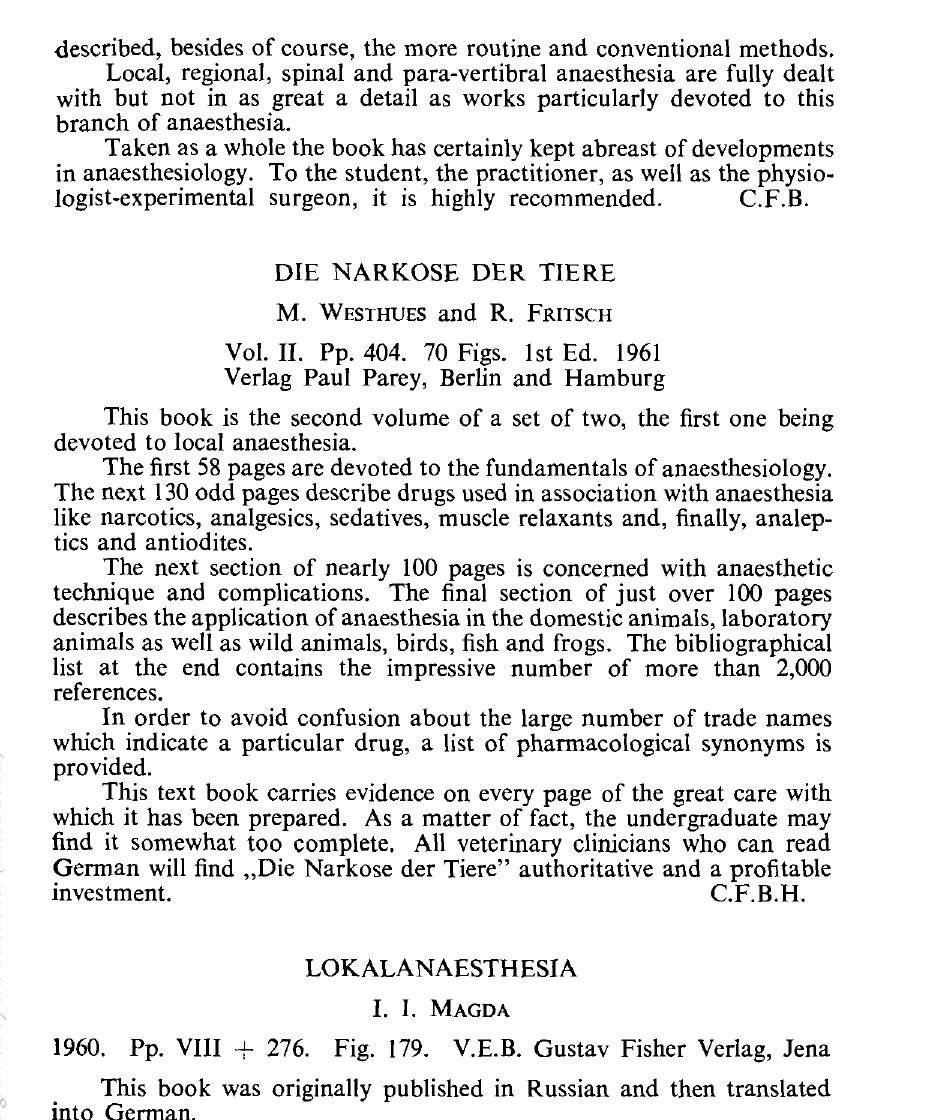
Fig. 179. V.E.B. Gustav Fisher Verlag,